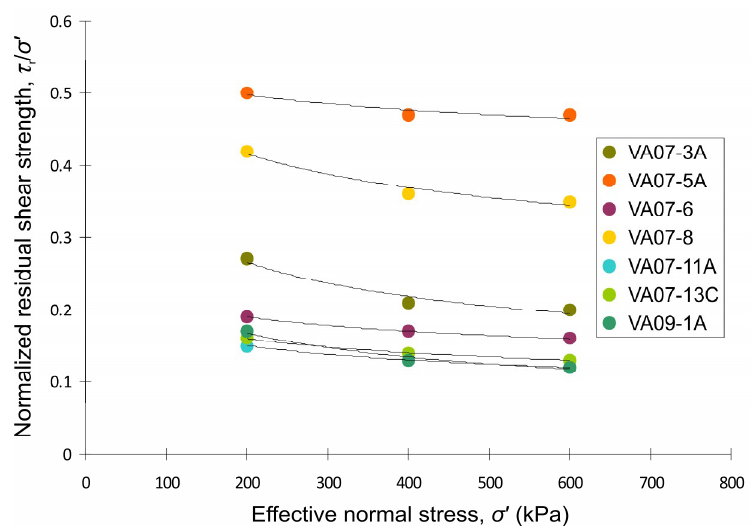
Figure 9. Normalized residual shear strength as a function of the effective normal stress for seven clay samples from Vajont.